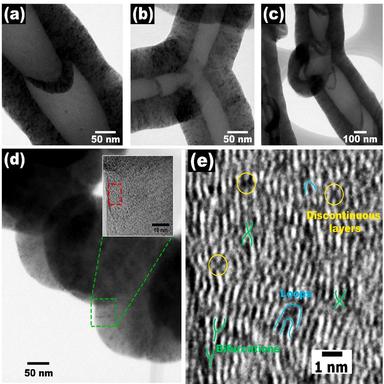
TEM images of NP-CNTSs. (a) Bamboo-shaped nanotube constructed by well-defined internal conical compartments. (b) Carbon nanotubes making a Yjunction with an internal bamboo shape morphology. (c) Carbon nanotube with an elbow and bamboo shape morphology. (d) TEM images show a carbon fiber, and the inset shows a high magnification image of the green square. (e) HRTEM images of the red square show the defective graphitic materials. The defects could be seen in loops, discontinuous layers, and bifurcations. (F